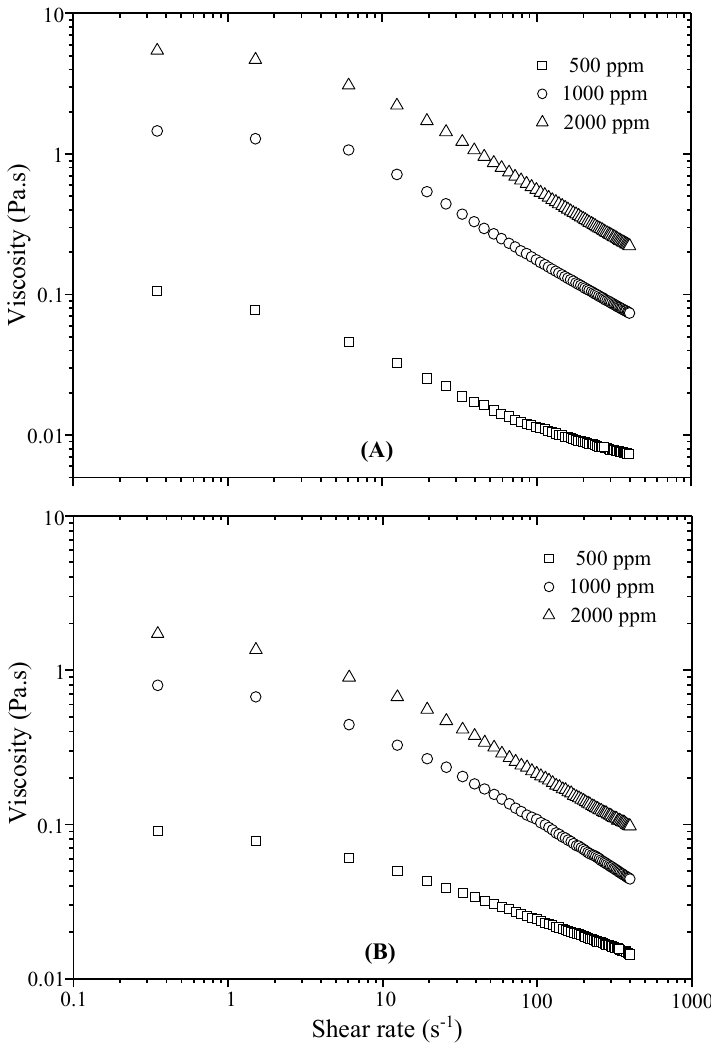
Figure 2. Influence of polymer concentration on shear viscosity for xanthan ( A ) and grafted xanthan ( B )-deionized water solutions.